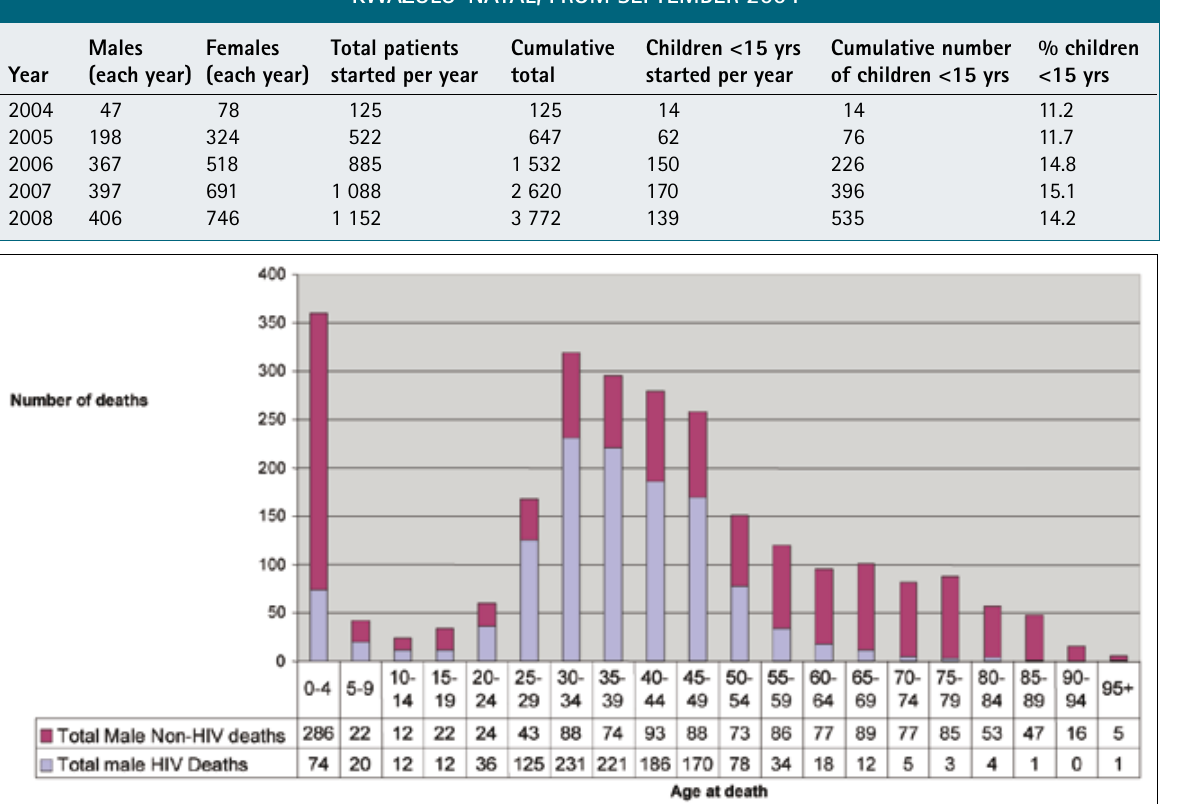
Fig. 1. Total male deaths 2003 - 2008 certified at Mosvold Hospital, Ingwavuma, northern KwaZulu-Natal, grouped according to HIV/AIDS-related and non-HIV/AIDS-related causes of death.